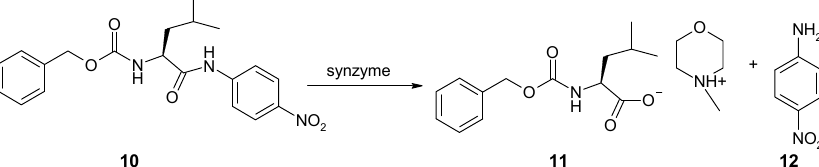
Figure 3. Hydrolysis of Z-Leu-NA ( 10 ) in the presence of synzyme leading to the formation of salt of Z-Leu-OH with NMM (Z-Leu-O − HNMM + , 11 ) and p -nitroaniline ( 12 ).